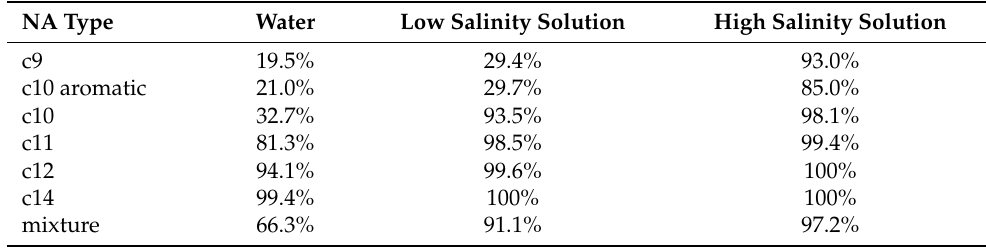
Table 2. Percentage of aggregation for the NAs averaged over the last 500 ns of MD